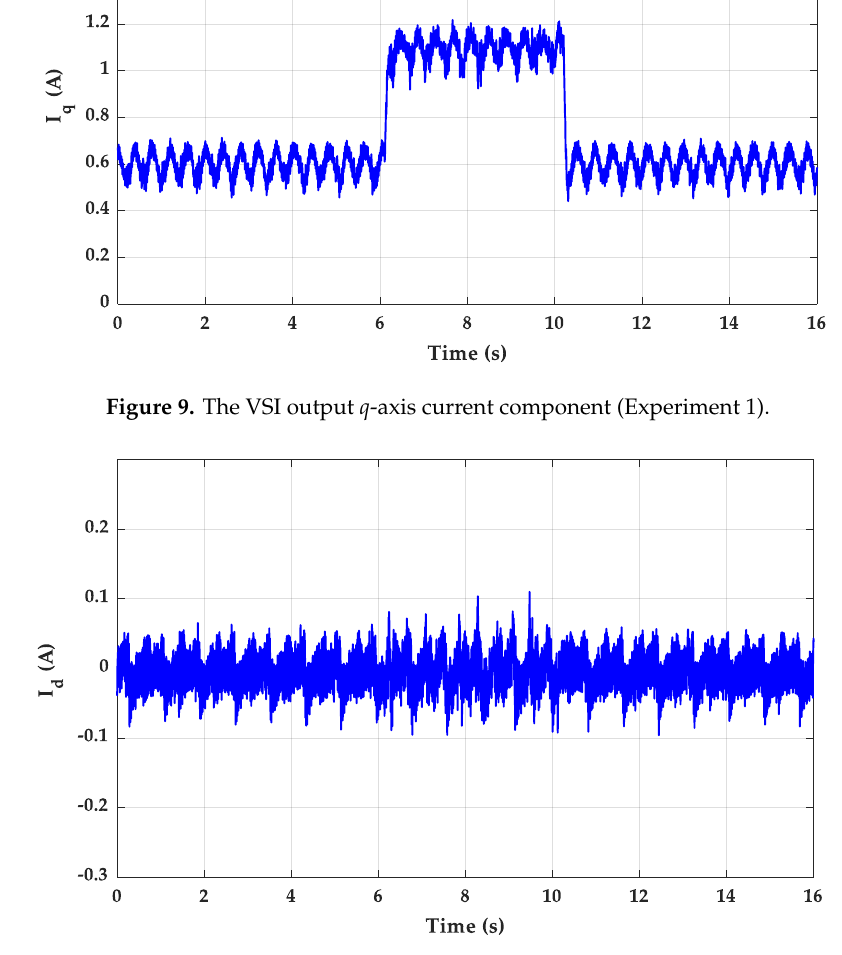
Figure 11. The dc-side voltage response (Experiment 1).